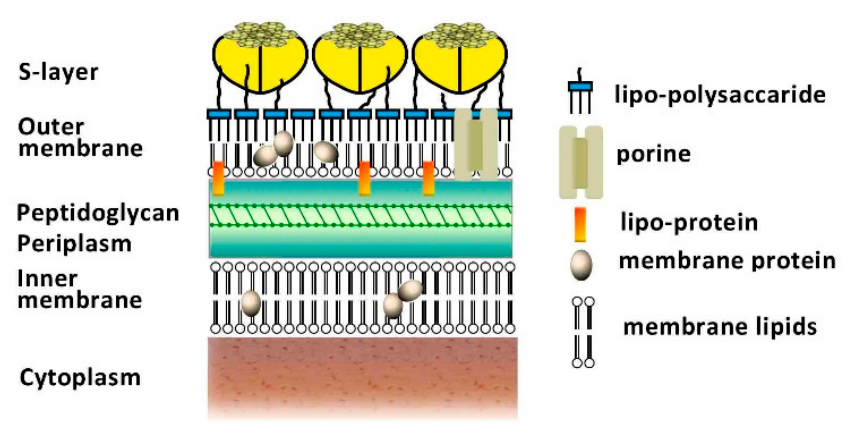
Figure 2. Typical structure of the envelope of a cyanobacterium (inspired from) [31,40,46].